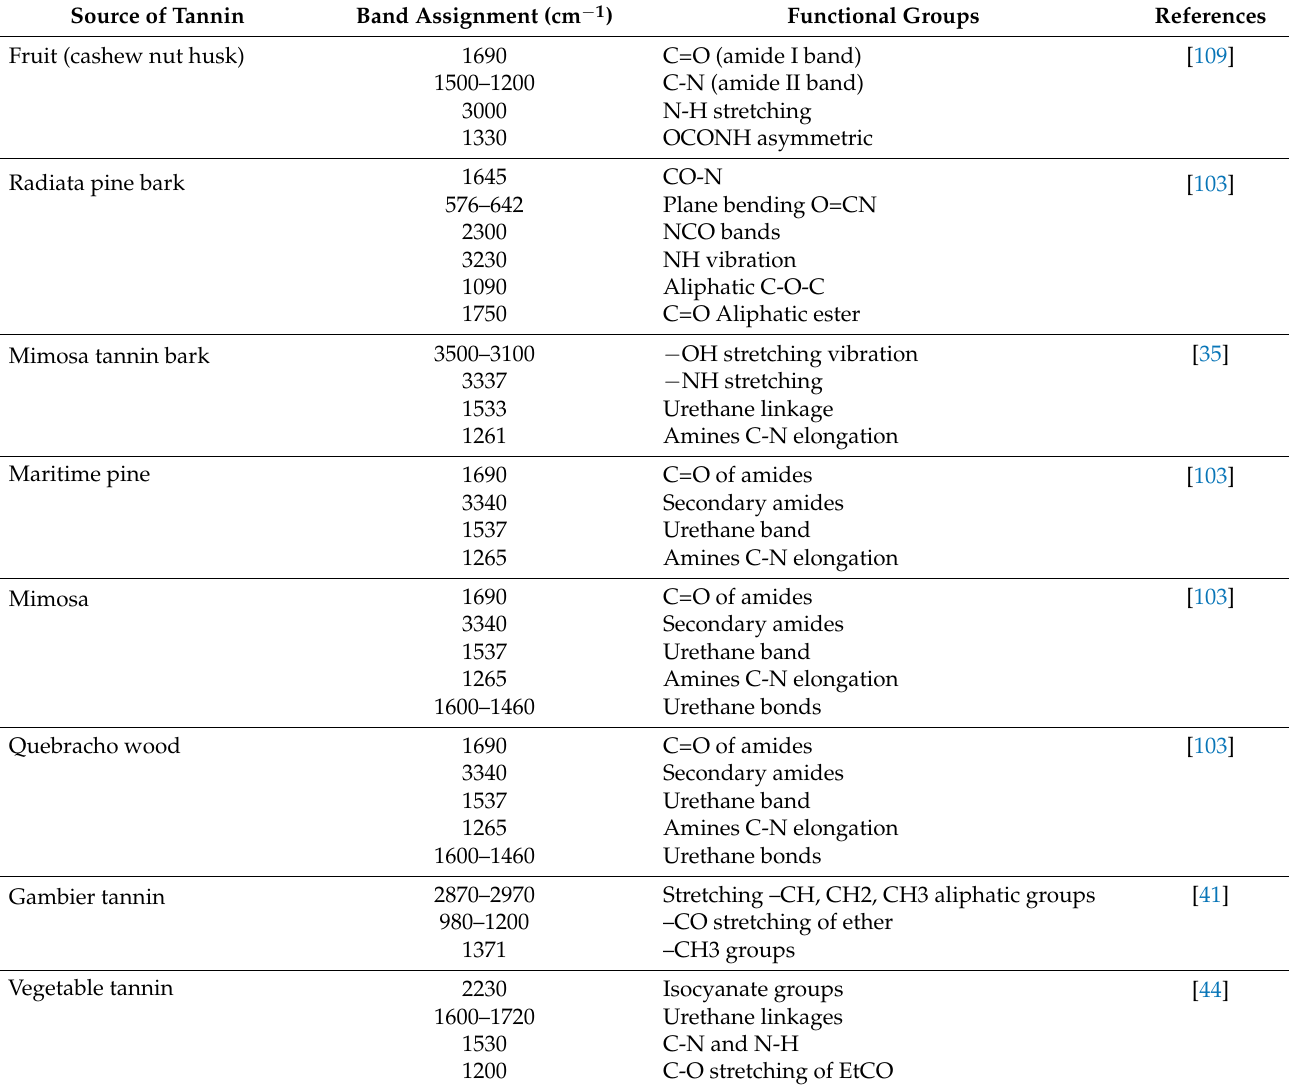
Table 3. FTIR spectroscopy analysis of bio-PU resins from different sources of